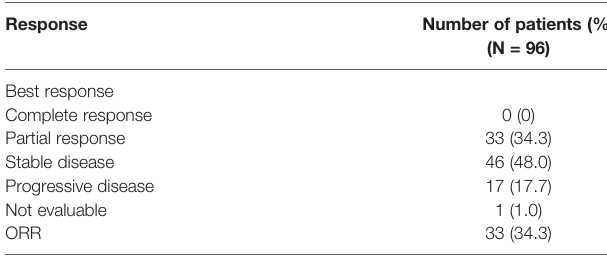
TABLE 3 | Objective response rate in all